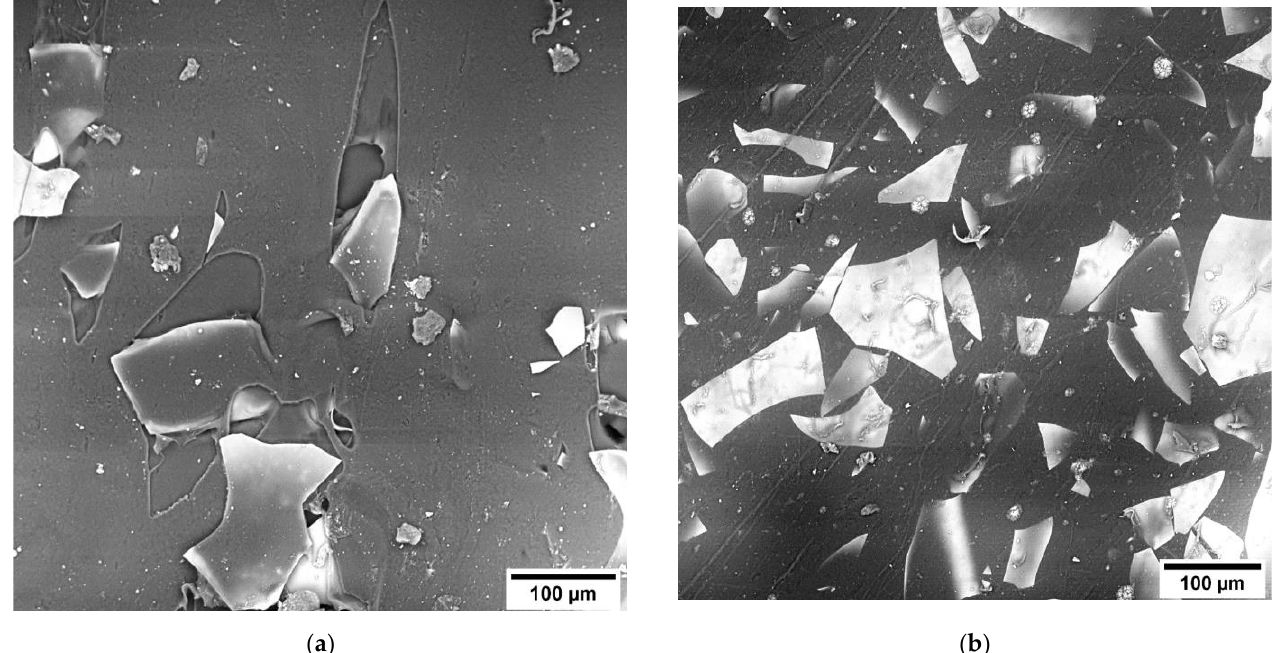
Figure 5. SEM images of the surface of samples with 10 ( a ) and 31 vol.% ( b )